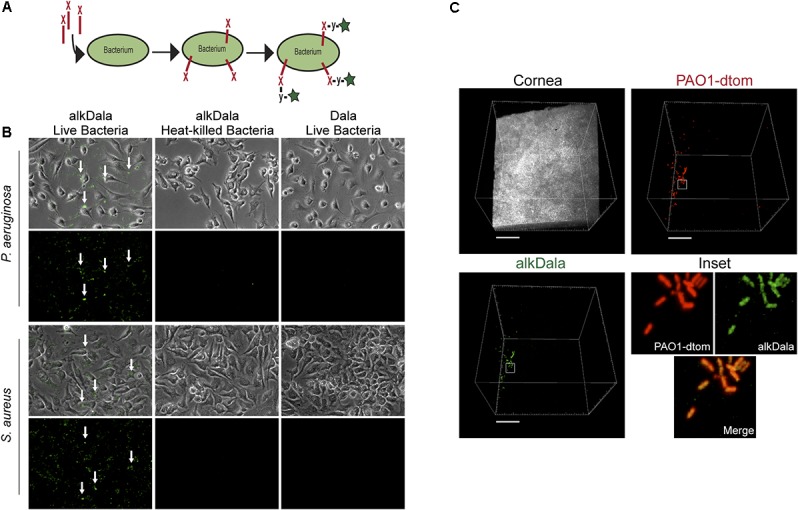
Alkyne-functionalized D-alanine (AlkDala) detects metabolically active bacteria inoculated onto cell culture and the murine cornea. (A) Schematic of alkDala (shown as a red X) labeling of bacteria. AlkDala is added to a bacterial suspension to allow incorporation into the cell wall peptidoglycan followed by a copper-catalyzed click-chemistry reaction with an azide-fluorophore (shown as a y-star symbol) to detect bacteria with incorporated probe. (B) AlkDala labeling was tested on Pseudomonas aeruginosa (PAO1) and Staphylococcus aureus (clinical isolate) in the presence of HeLa cells, and labeled all live bacteria (green, arrows) (Lower Left). Heat-killed bacteria were not detected (Lower Middle), nor were live bacteria detected if incubated with D-alanine without an attached alkyne (Lower Right). (Upper) show the phase-contrast images of respective fields. (C) To determine if bacteria on the murine ocular surface could be labeled with alkDala, whole eyeballs were incubated in ∼1011 CFU/mL of red fluorescent P. aeruginosa (PAO1-dtom) for 5 h, and then labeled using alkDala (green). The same fields of view are shown with different emission filters. Inset shows zoom of the white box with merge. Scale bar, 50 μm.